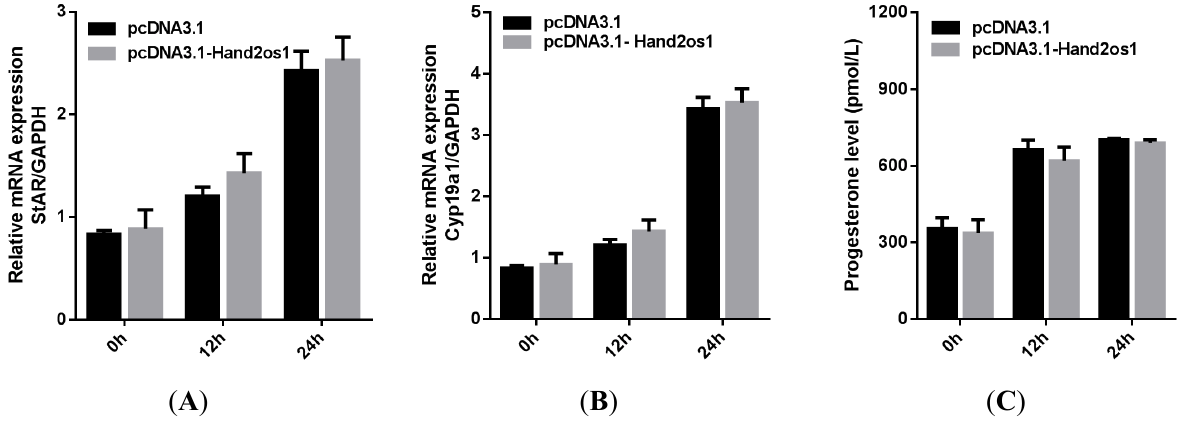
Figure 4. Expression analyses of StAR , Cyp11a1 , and Hand2os1 during luteinization of granulosa cells. The mRNA levels of ( A ) StAR , ( B ) Cyp11a1 , and ( C ) Hand2os1 were detected by qRT-PCR after primary granulosa cells were treated with 100 ng/mL LH for 0, 12, and 24 h. GAPDH was used as the reference gene for normalization. The data represent the mean ± SEM from three independent experiments. b ( p < 0.05), c ( p < 0.01) compared with 0h group (a), the same letter indicates no significant difference and different letters means significant difference ( p < 0.05).